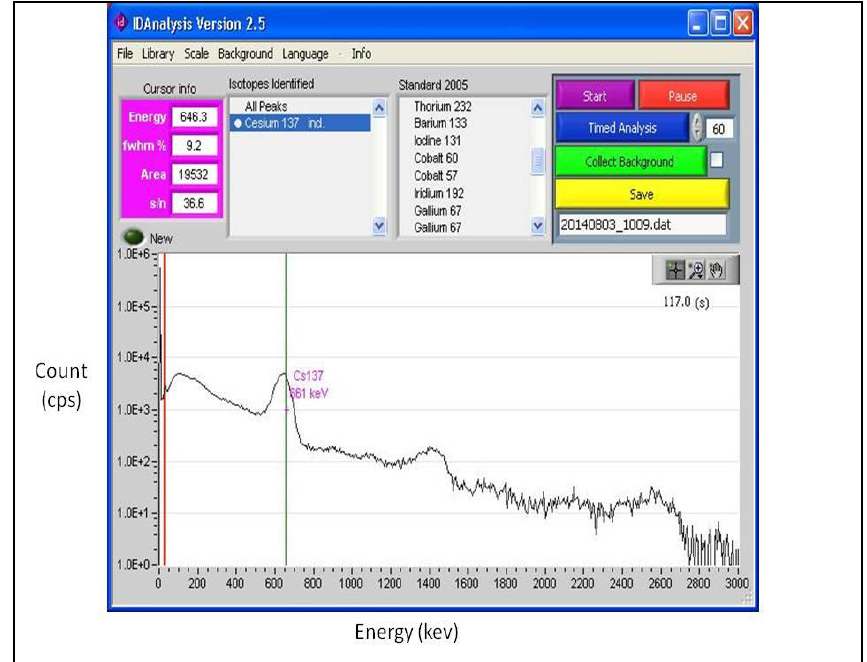
Fig. 9: Spectrum display of radioactive source